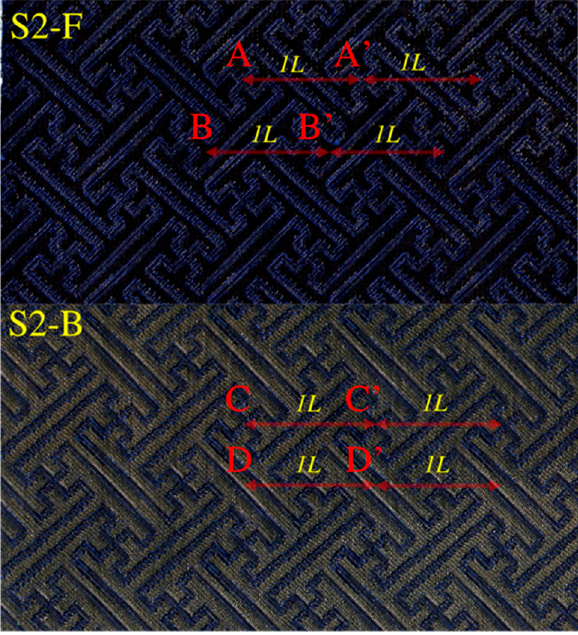
Figure 9. Description for the measurement of the surface resistance of the sample S2.